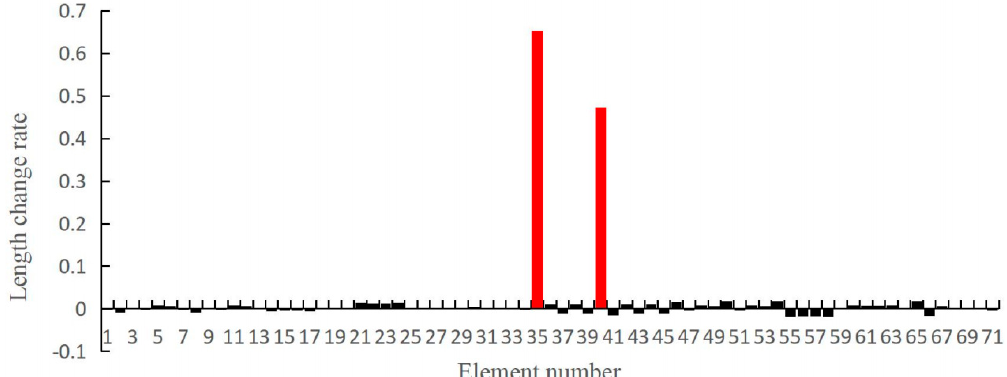
Figure 5. Rate of change of element length obtained from the static data (elements 35 and 40 were damaged with no noise).